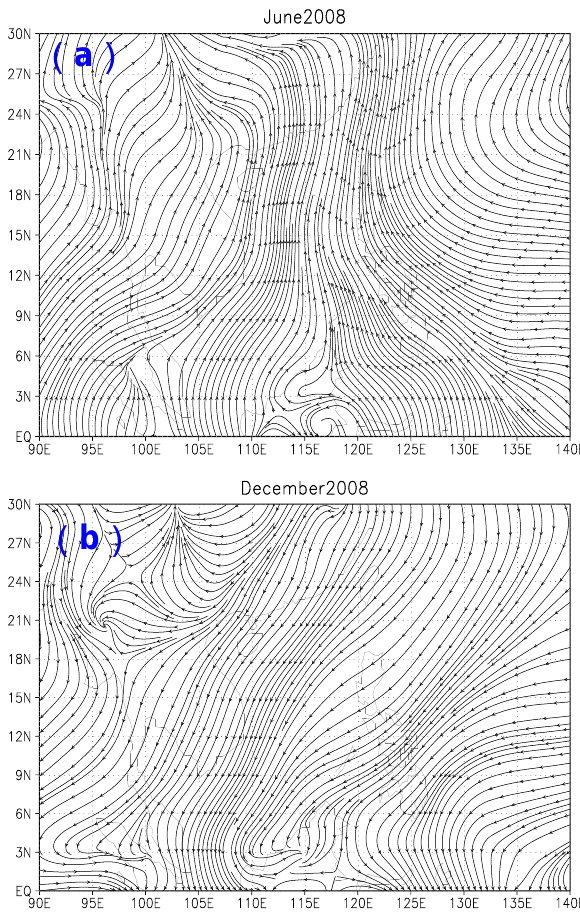
Figure 4 . South China Sea monthly average wind stream maps in (a) June 2008, South China Sea monsoon and (b) December 2008, Northeast monsoon